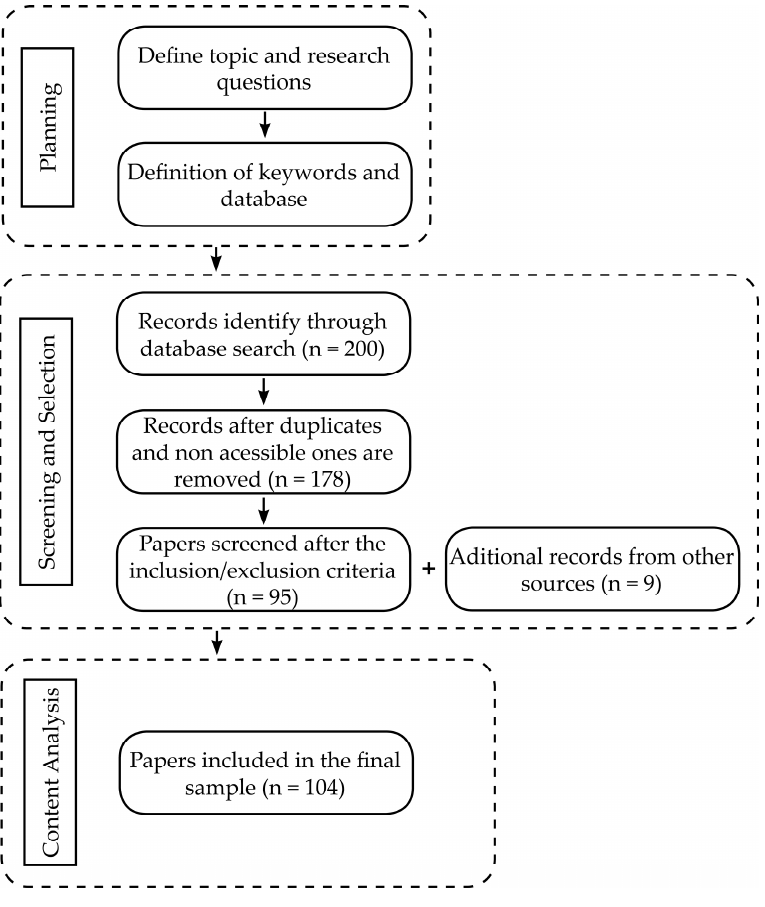
Figure 1. Overview of the methodological approach adapted from Klein et al. [66].